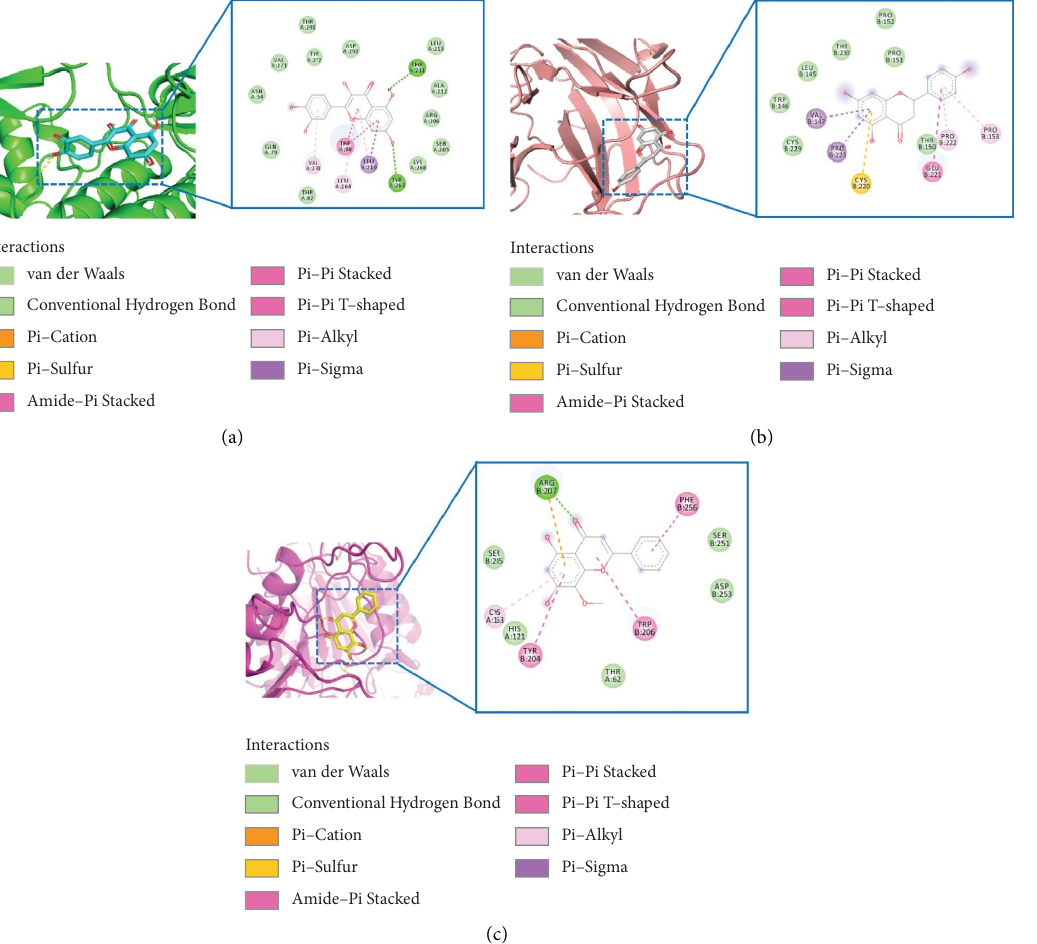
Figure 7: Te molecular docking analysis of (a) AKT1 binding with quercetin, (b) TP53 binding with wogonin, and (c) CASP3 binding with (2R)-5,7-dihydroxy-2-(4-hydroxyphenyl) chroman-4-one. Hydrogen bonds, pi-pi stacked, pi-sigma, and van der Waals forces contributed to the interaction between the targets and the ingredients.